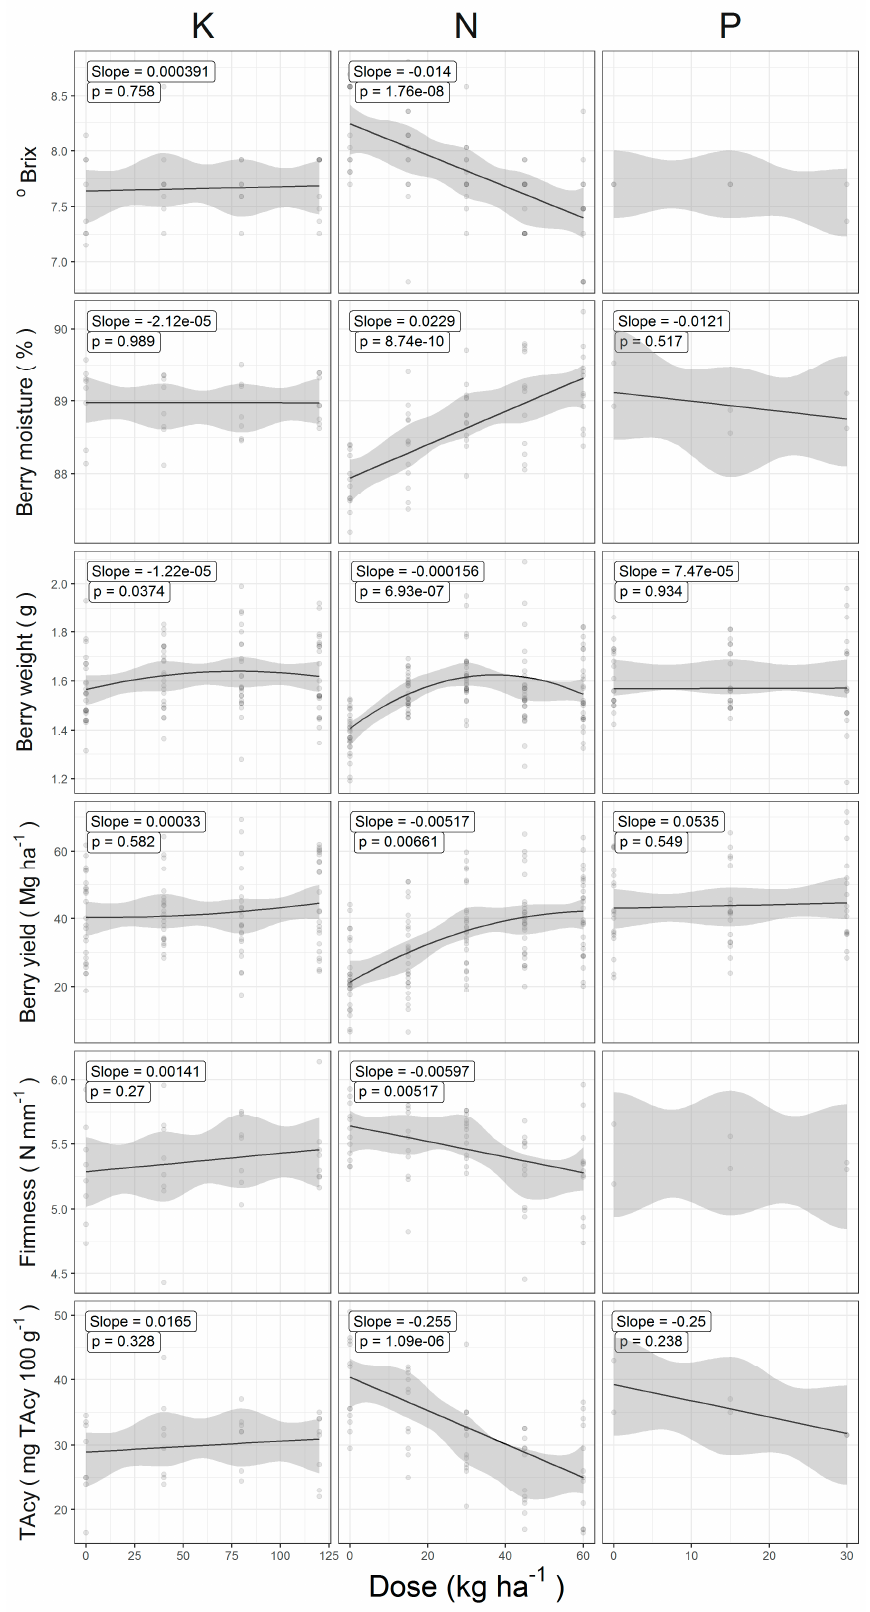
Figure 4. Response of berry yield, weight, and quality indices to added N, P, and K. The solid line represents the model fit with the slope and intercept of the line; the shaded area represents the 95% confidence